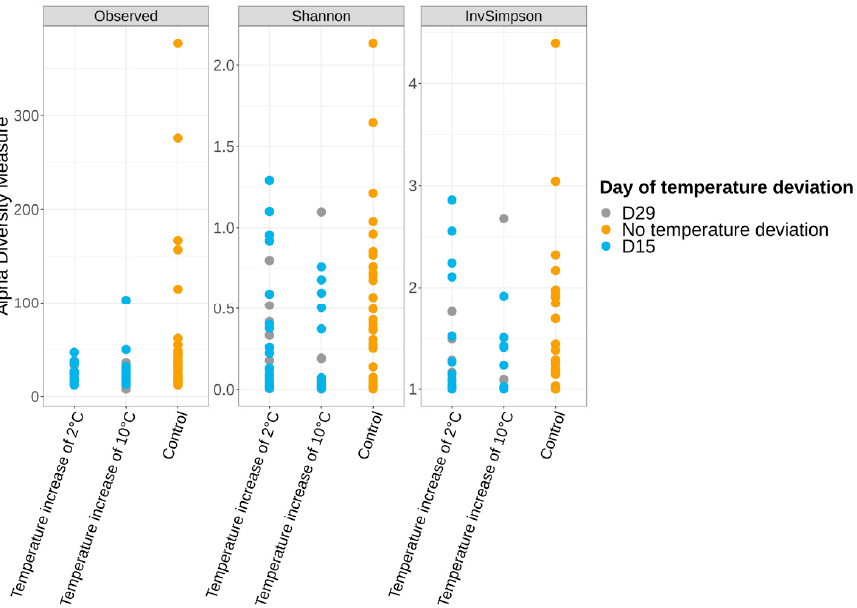
Figure 6. Alpha diversity measures among the control samples and samples that were subjected to a temperature increase of 2 °C or 10 °C, carried out at day 15 and 29 and sampled at day 56.